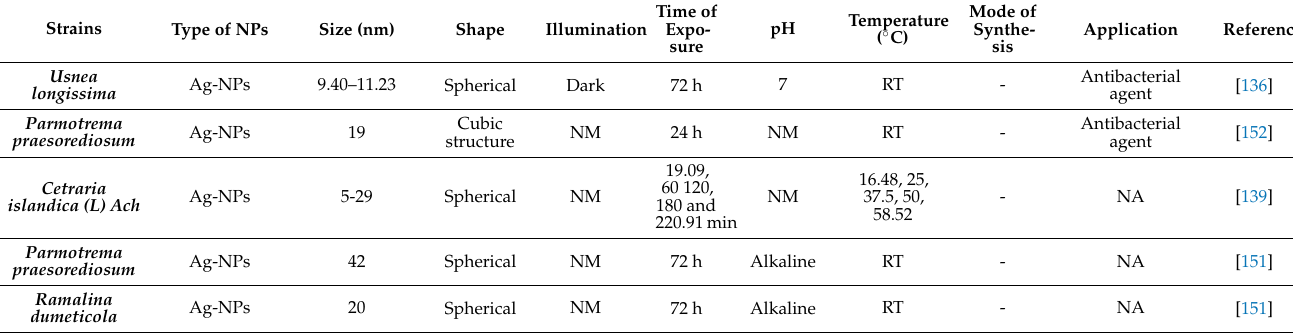
Table 1. Lichen-based synthesis of nanoparticles